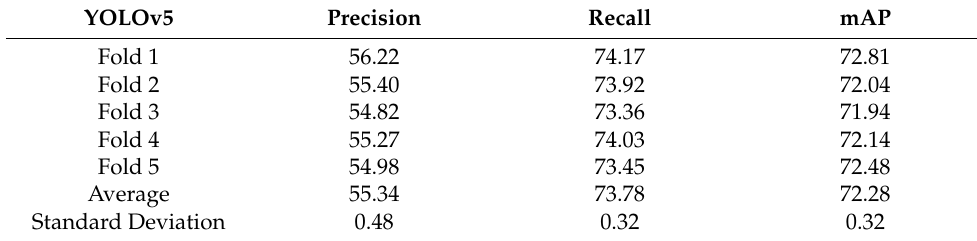
Table 4. Results of 5-fold cross-validation from YOLOv5.